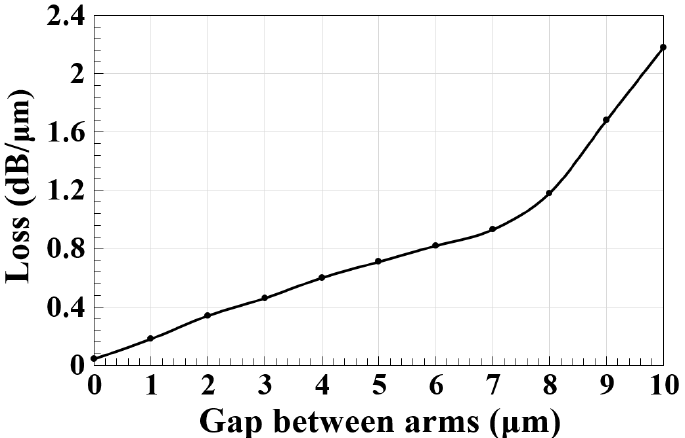
sults in a loss increase.